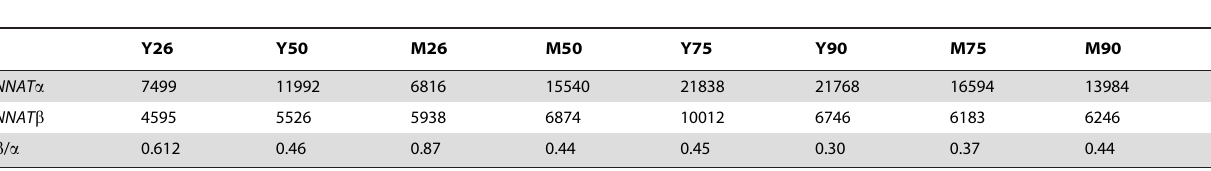
Table 1. Ratios between NNAT a / b